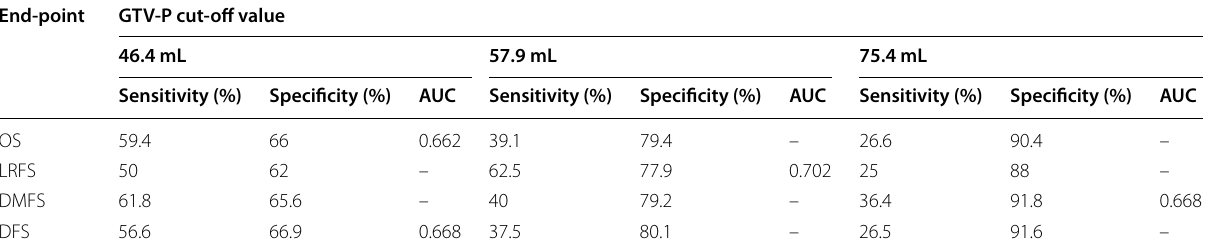
Twelve patients were lost to follow-up and, thus, were not included in the survival analysis AUC area under the curve, OS overall survival, LRFS local relapse-free survival, DMFS distant metastasis-free survival, DFS disease-free survival – AUC of inferior cut-off value for the endpoint was not calculated